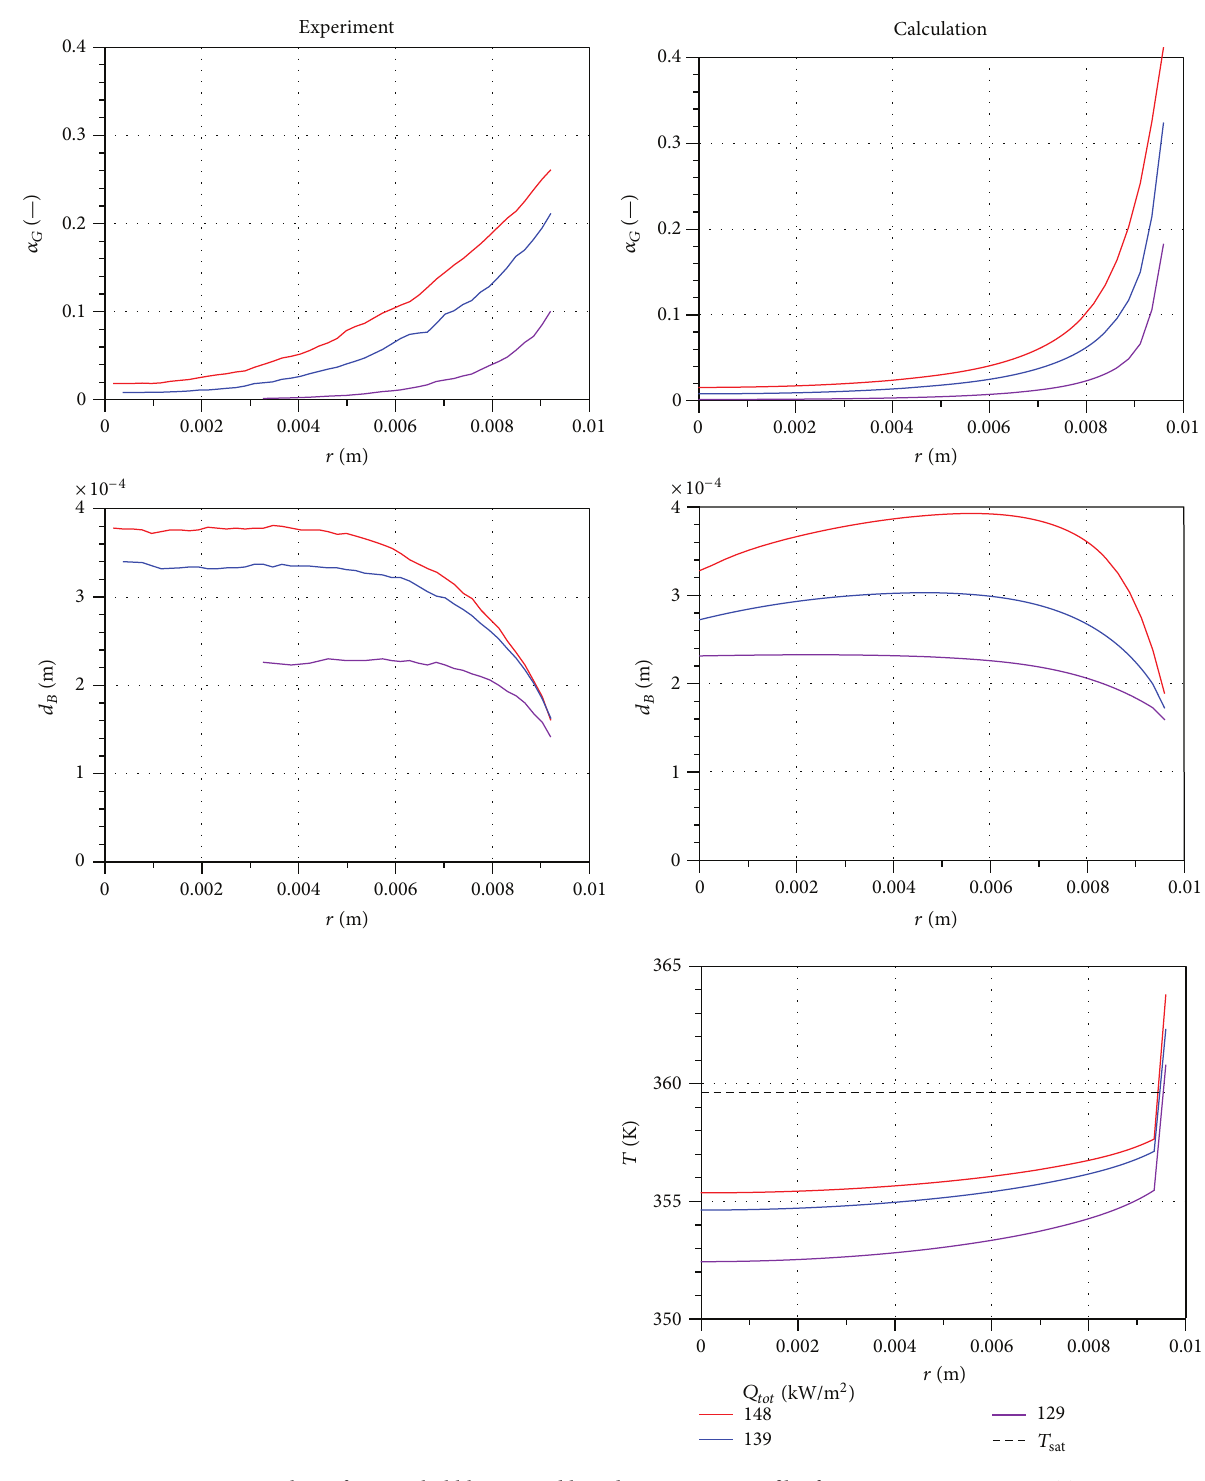
F 11: �as �olu�e fraction� �u��le si�e� and li�uid te��erature �ro�les for test series